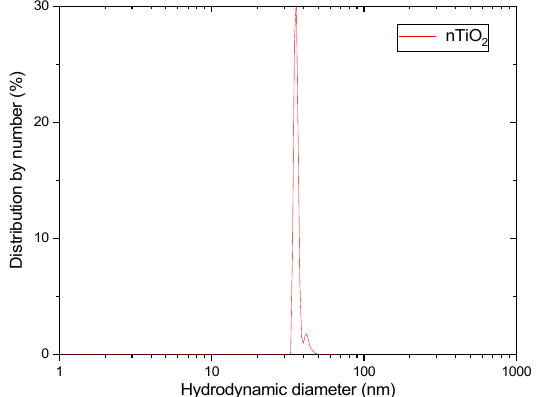
Figure 1. Particle size distribution by number (dilution 1:20).